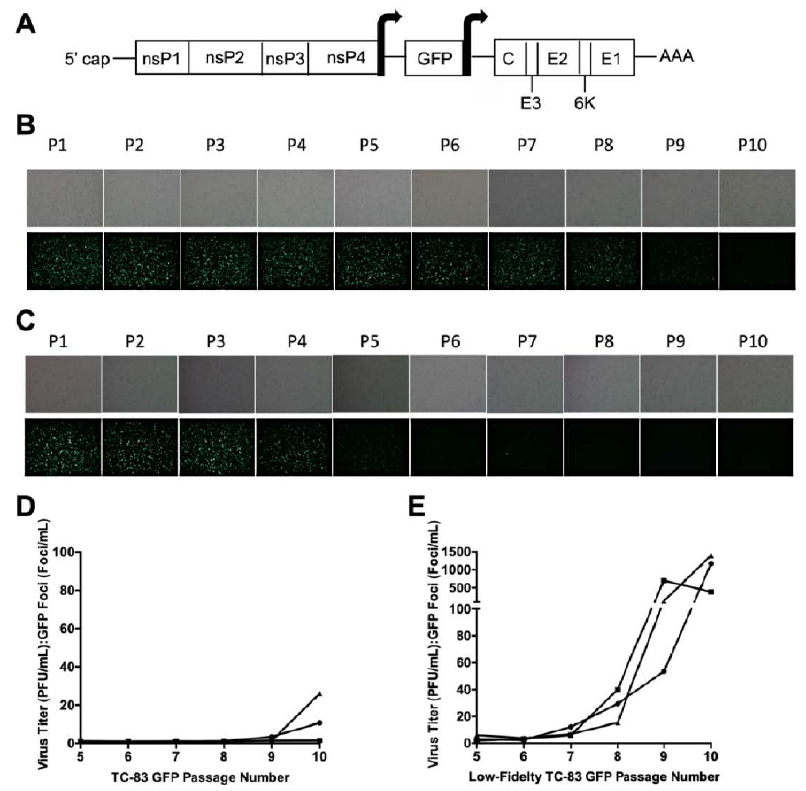
Figure 1. Loss of GFP fluorescence during passage. Genome schematic of TC-83 GFP ( A ). The arrows surrounding the GFP gene represent the subgenomic promotor sequences. Vero cells were infected with TC-83 GFP ( B ) or low-fidelity TC-83 GFP ( C ) over the course of 10 virus passages. The first replicate for each virus is depicted. Upper panels show brightfield microscopy images, while lower panels show GFP fluorescence. P: passage. The ratio of the PFU:GFP foci was determined for passages 5–10 to estimate the loss of GFP fluorescence for TC-83 GFP ( D ) and the low-fidelity TC-83 GFP ( E ). Replicate 1: circle, replicate 2: square, replicate 3: